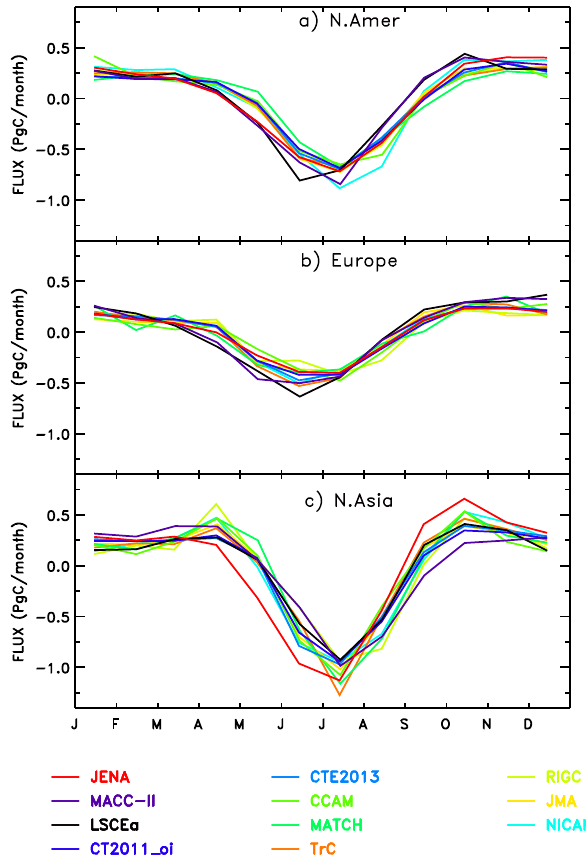
Fig. 10. Same as Fig. 9 but the breakdown of the land North- ern Hemisphere fluxes into (a) North America, (b) Europe, and (c) North